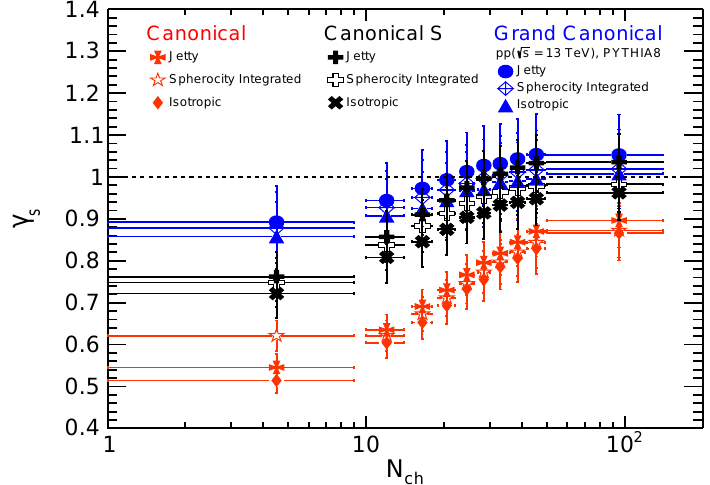
Figure 8. The strangeness saturation factor ( γ s ) as a function of the charge particle multiplicity ( N ch ) and spherocity classes (shown by different markers) for the canonical, strangeness canonical, and grand canonical ensembles. The red and black points are obtained using the canonical ensemble and the strangeness canonical ensemble, respectively, whereas the blue points are for the grand canonical